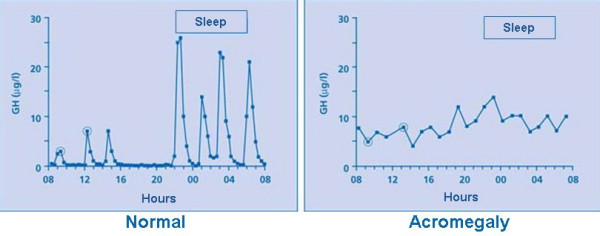
Frequent blood sampling with serum GH measurement shows that in normal subjects (left panel) GH can fluctuate between undetectable levels (most of the time) and peaks of up to 30 μg/l (90 mIU/l), owing to the episodic nature of GH secretion, while in patients with acromegaly (an example is given on right panel), GH hypersecretion is continuous and GH never returns to undetectable levels.